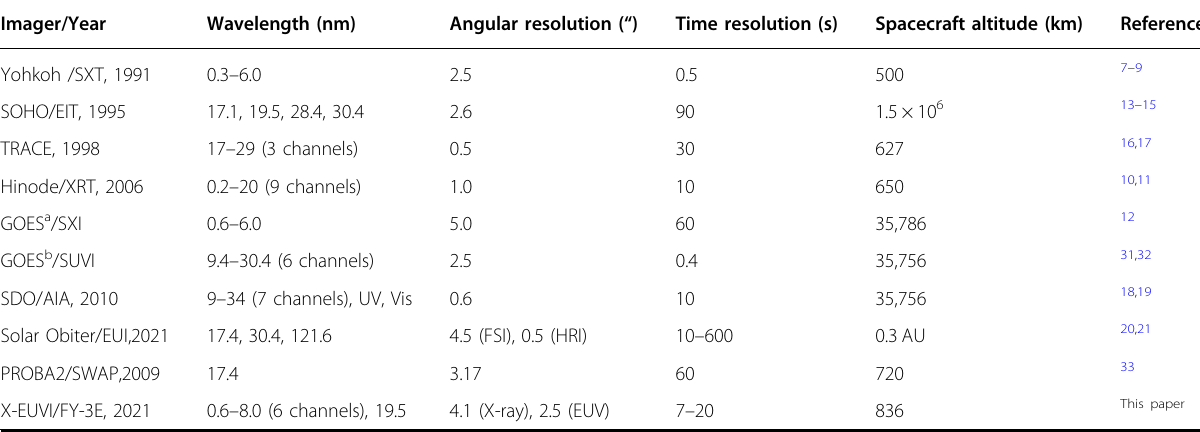
Table 1 Summary of typical solar imagers